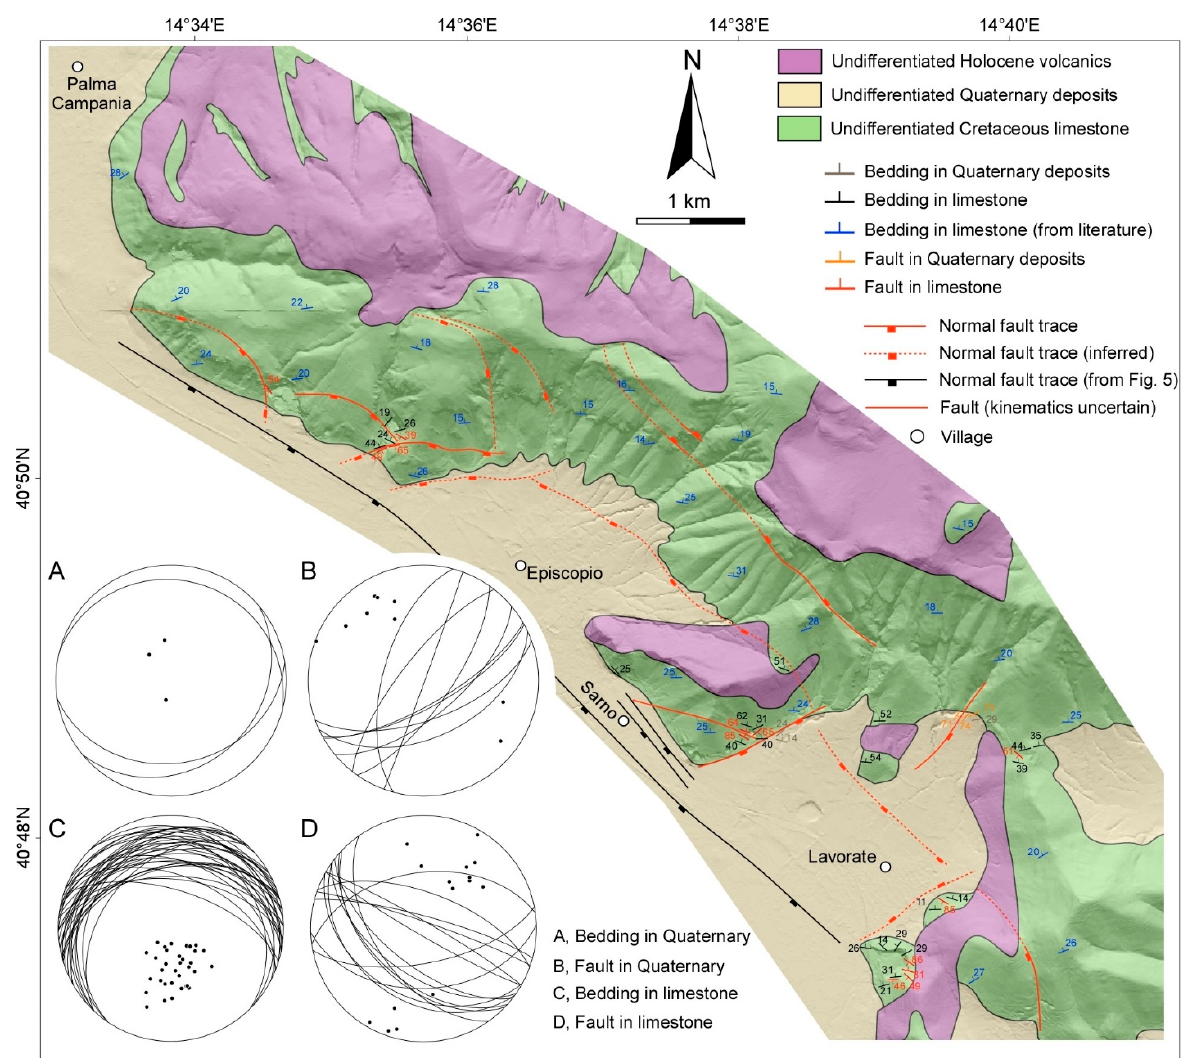
Figure 6. Geological map of the Sarno Mountains with plots showing the spatial arrangement of bedding and fault data throughout the map area.